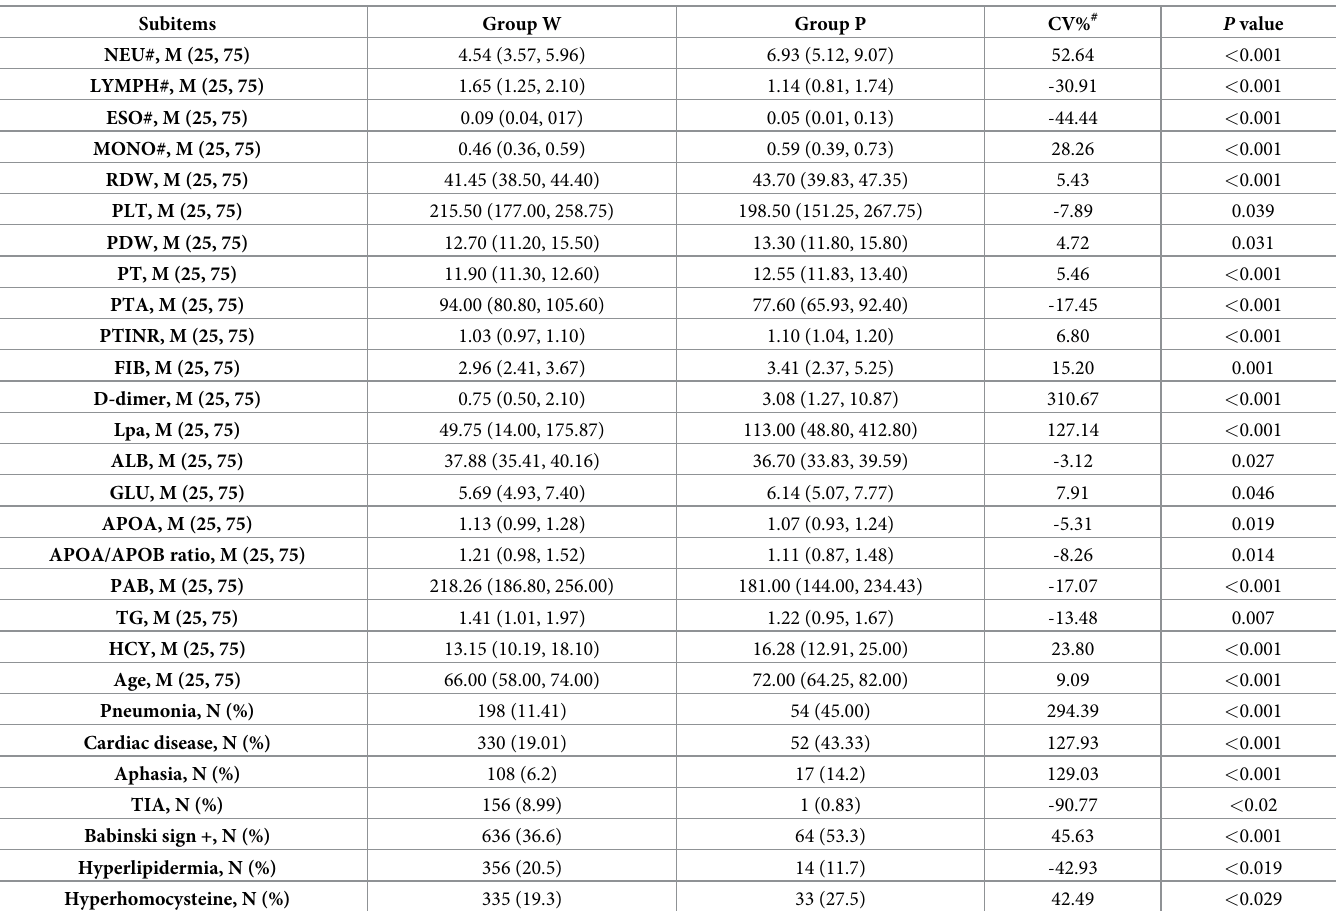
Table 1. Compared result of significant subitems between Group W and Group